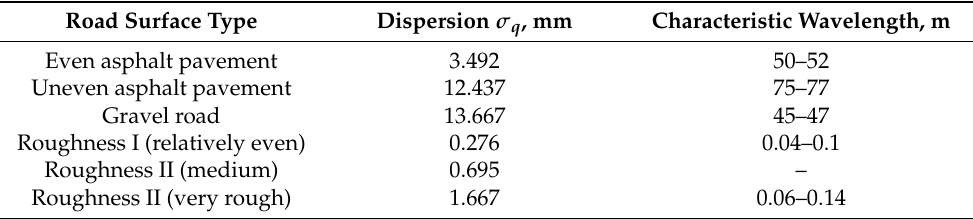
Table 1. Microprofile and roughness characteristics of the investigated road surfaces.